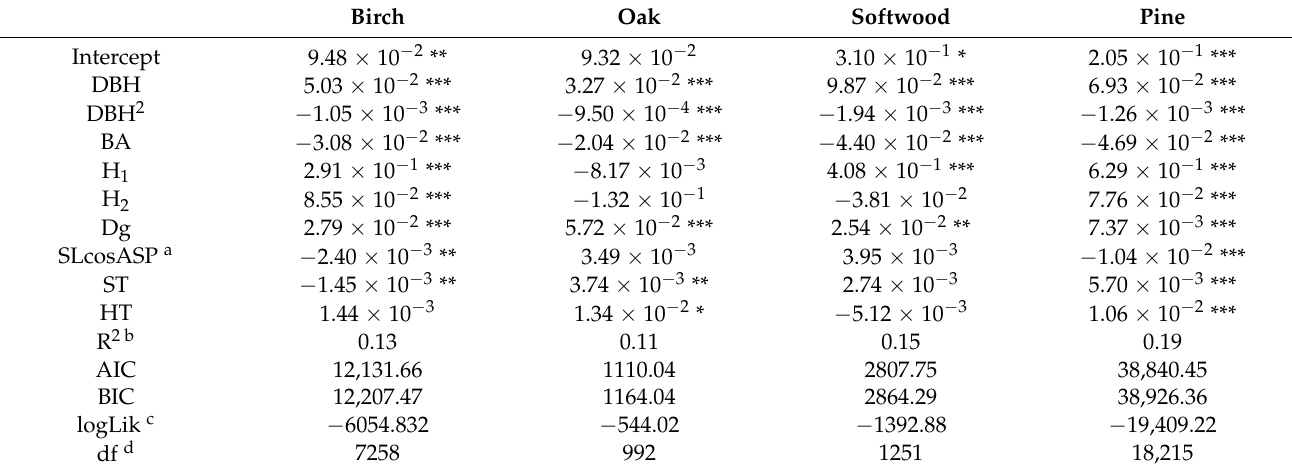
Table A1. The estimated parameters with lack-of-fit statistics for the tree diameter increment model of NCM. The dependent variable, diameter increment, was measured in centimeters per five years. Birch Oak Softwood